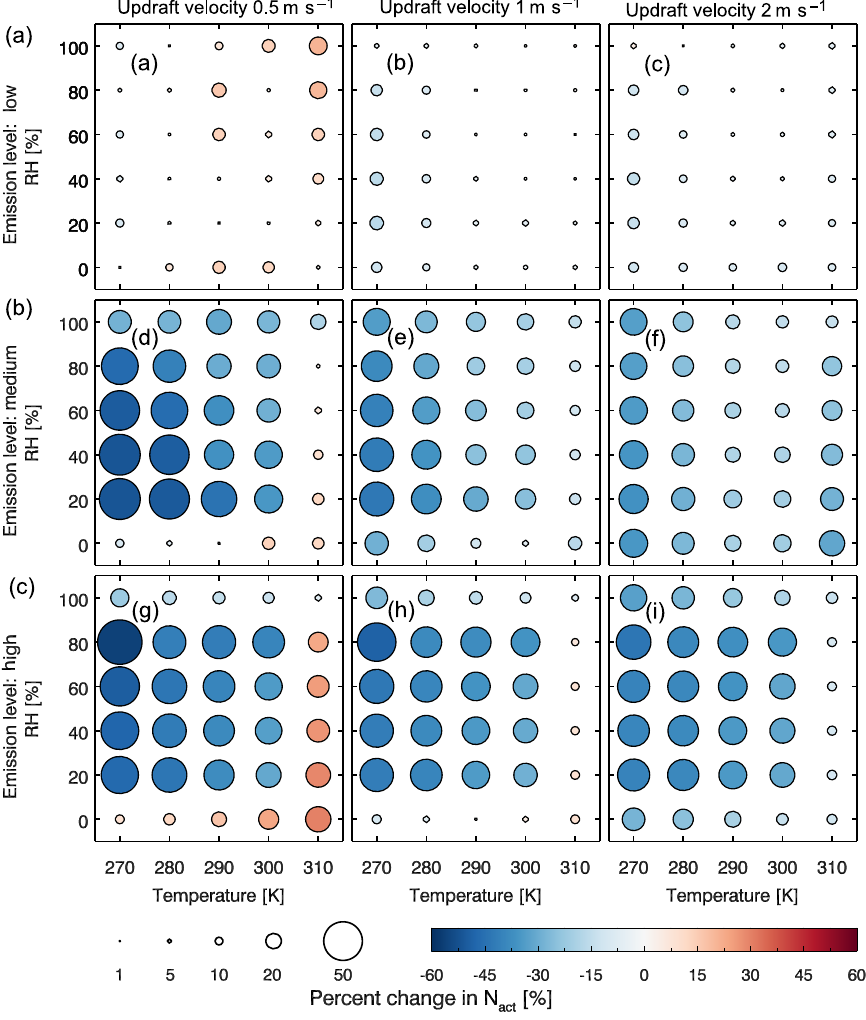
Figure 2. Fractional change of the average activated number concentration (size and color of the circles) over the last 24h of a 5-day simulation between the two models with low-level (a, b, c) , medium-level (d, e, f) , and high-level (g, h, i) emissions at updraft velocities of 0.5 (a, d, g) , 1 (b, e, h) , and 2 (c, f, i) ms − 1 . Table 3. Minimum and maximum of fractional change in average activated number concentration over the last 24h between the two models with low-, medium-, and high-level emissions at updraft velocities of 0.5, 1, and 2ms − 1 . Fractional change in activated number concentration Updraft velocity (ms − 1 ) 0.5 1